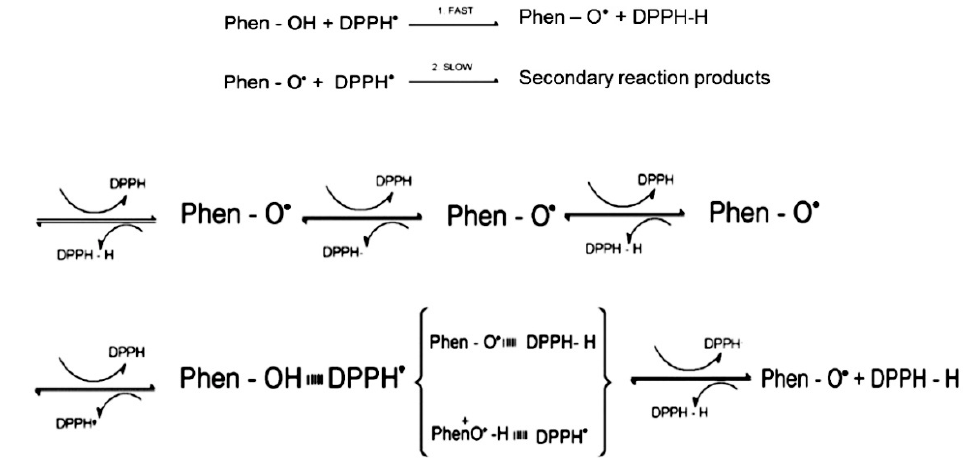
Figure 1. Schematic representation of the reaction between 2,2-diphenyl-1-picrylhydrazyl (DPPH)• radical and a generic polyphenolic compound (Phen-OH).